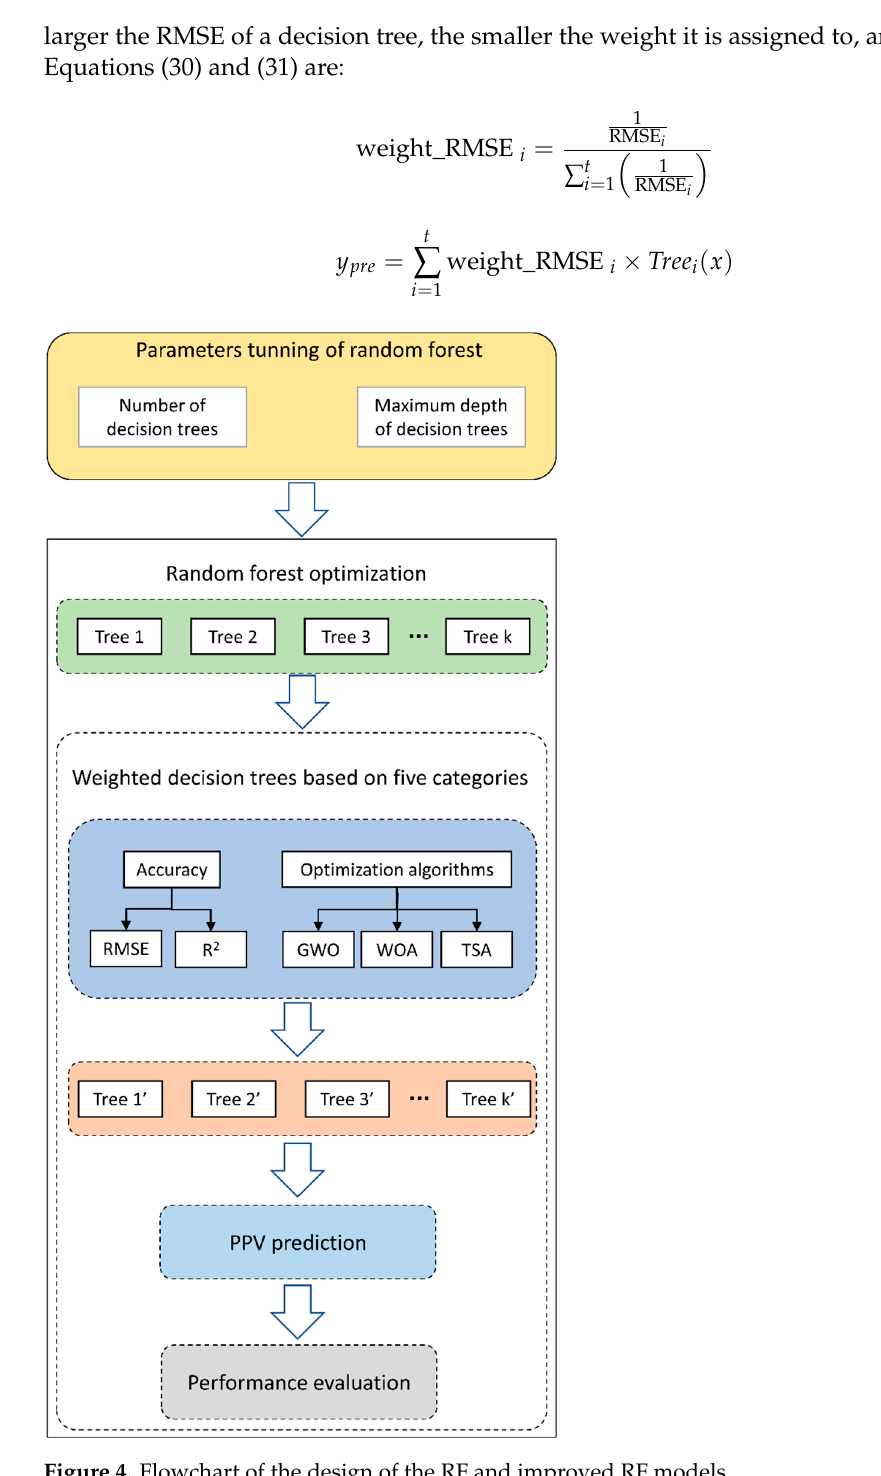
Figure 4. Flowchart of the design of the RF and improved RF models.